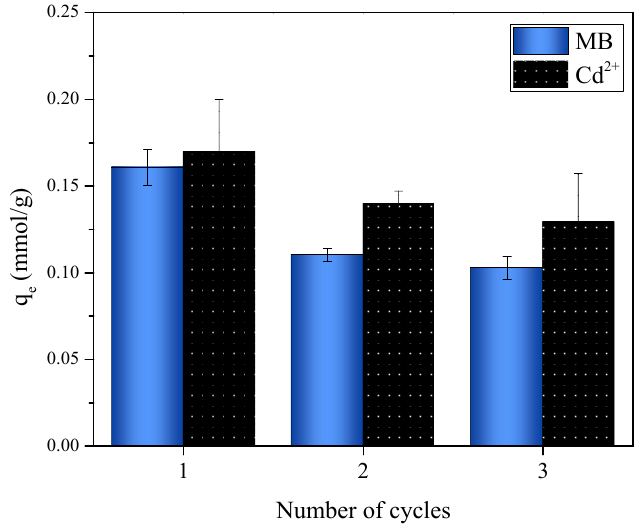
Figure 8. Regeneration of OP for the adsorption of MB and Cd 2+ in a multicomponent system.